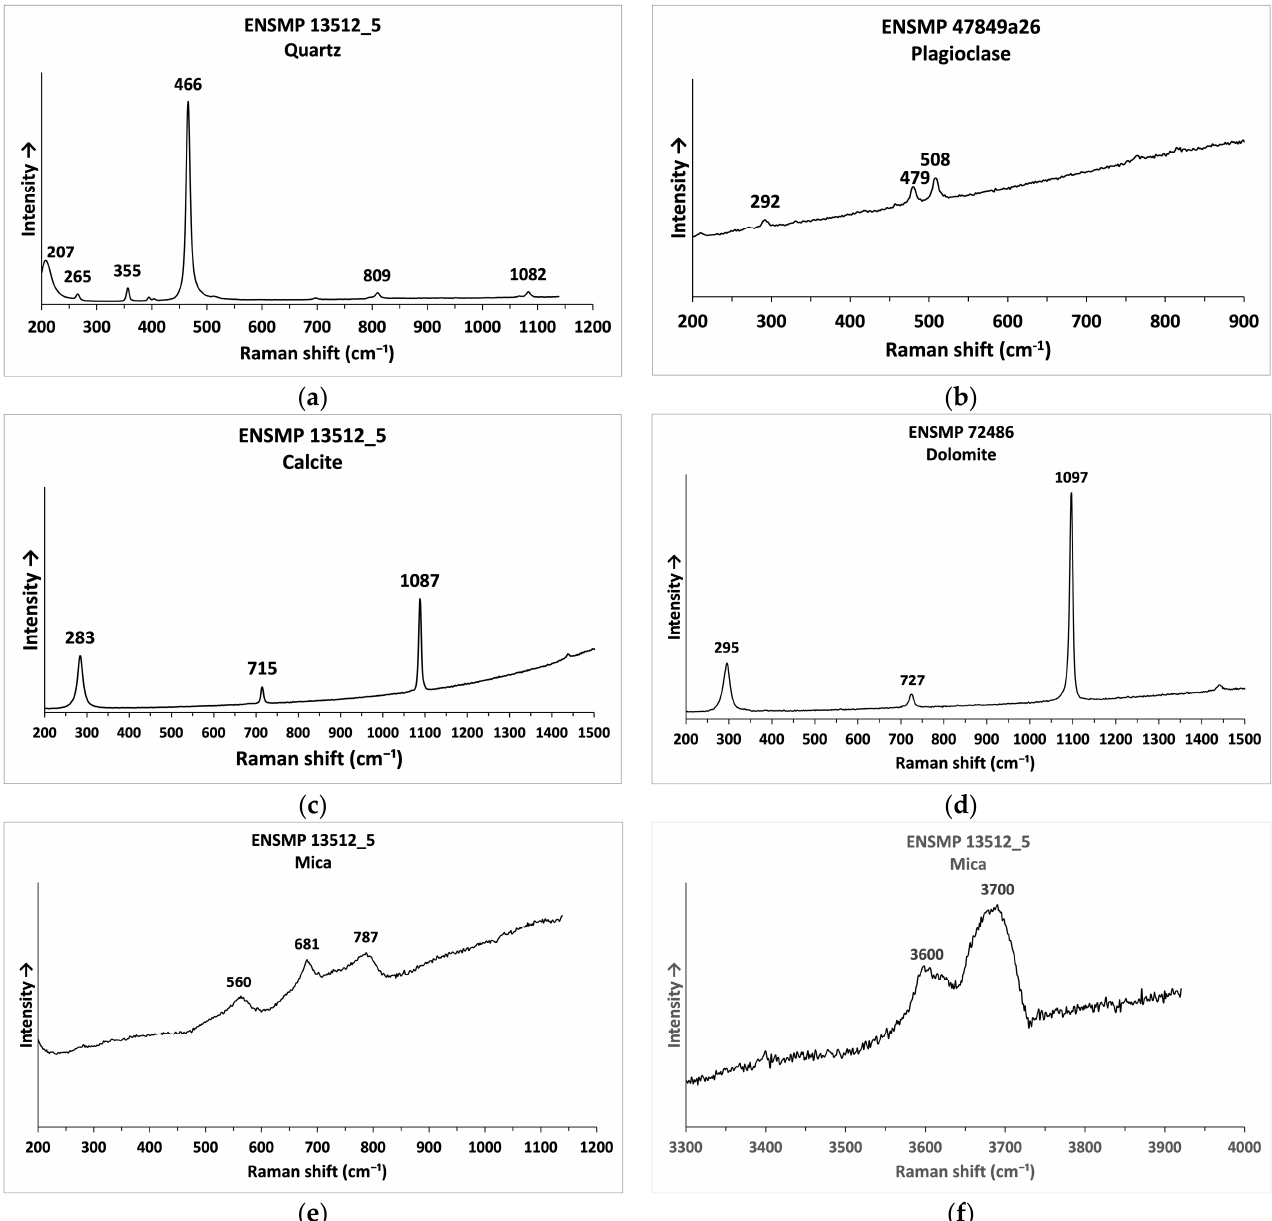
Figure 11. Micro-Raman spectra of minerals from the host rock of the Egyptian emeralds. ( a ) Raman spectra of quartz crystal (ENSMP 13512_5), ( b ) Raman spectra of plagioclase (ENSMP 47849a26), ( c ) Raman spectra of calcite (ENSMP 13512_5), ( d ) Raman spectra of dolomite (ENSMP 72486), ( e , f ) Raman spectra of mica (phlogopite) (ENSMP 13512_5).